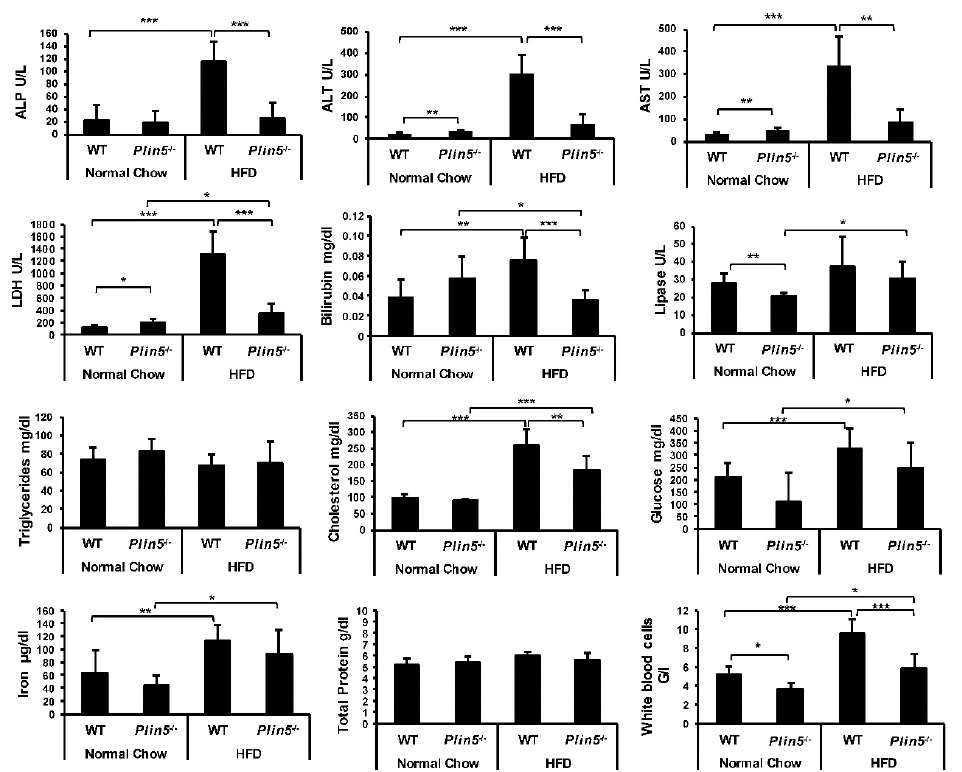
Figure 3. Absence of Perilipin 5 prevents high-fat diet (HFD)-induced liver injury. Serum and whole blood analysis from wild type (WT) and Plin5 − / − mice fed either a normal chow or HFD for 30 weeks ( n = 4–7 animals / group). Serum analysis showed that enzymes such as alkaline phosphatase (ALP), aspartate aminotransferase (AST) and alanine transaminases (ALT) after HFD were only increased in WT. Lactate dehydrogenase (LDH), bilirubin, lipase, cholesterol, glucose, iron and white blood cells were differentially present among the different groups. Total protein and circulating triglycerides were present in all groups without statistical differences. Data are expressed as mean ± SD. Statistical analysis was performed with Student’s t -test. * p < 0.05; ** p < 0.01; *** p < 0.001.